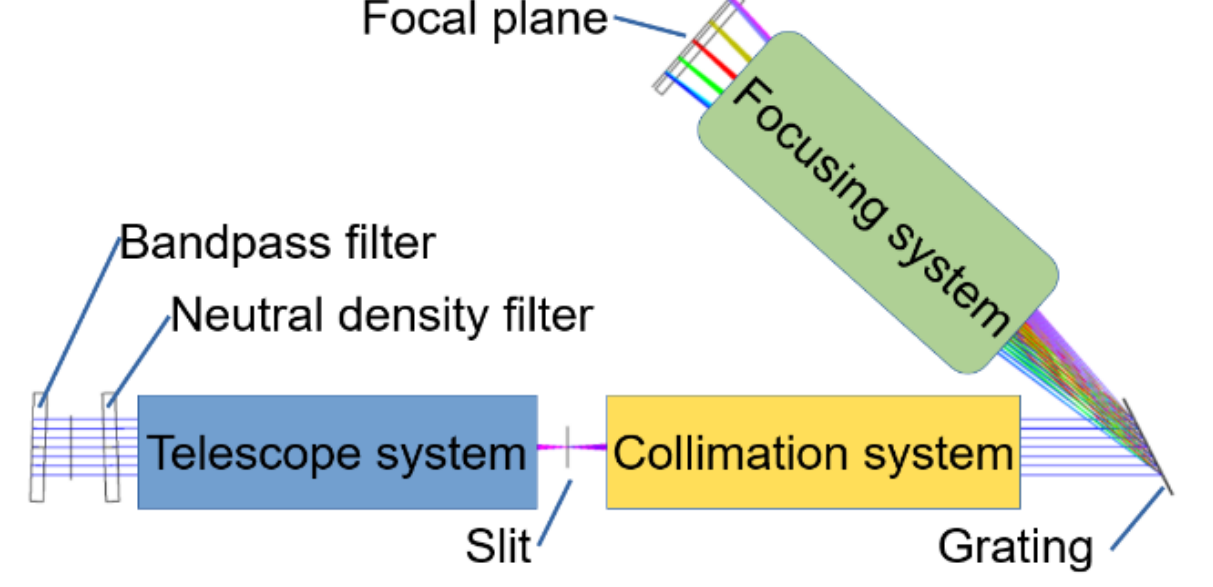
Figure 1. Layout for the optical system based on HARIS.